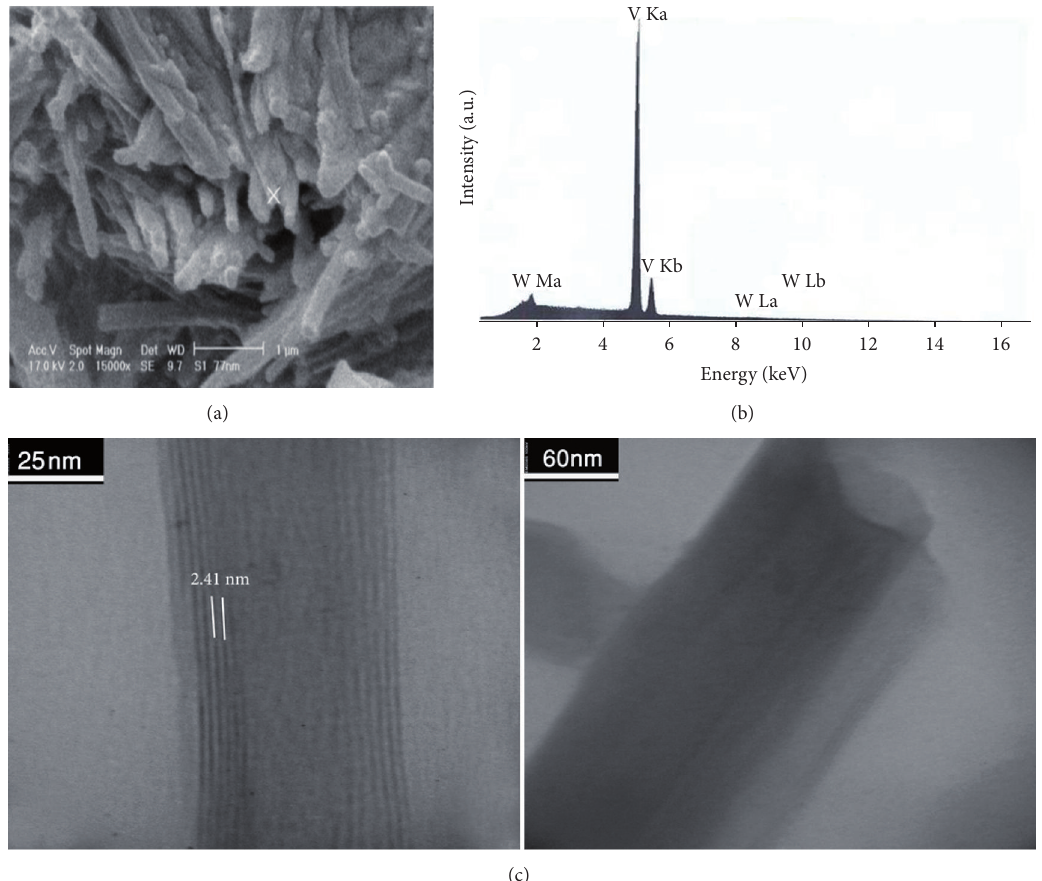
different ranges of 2